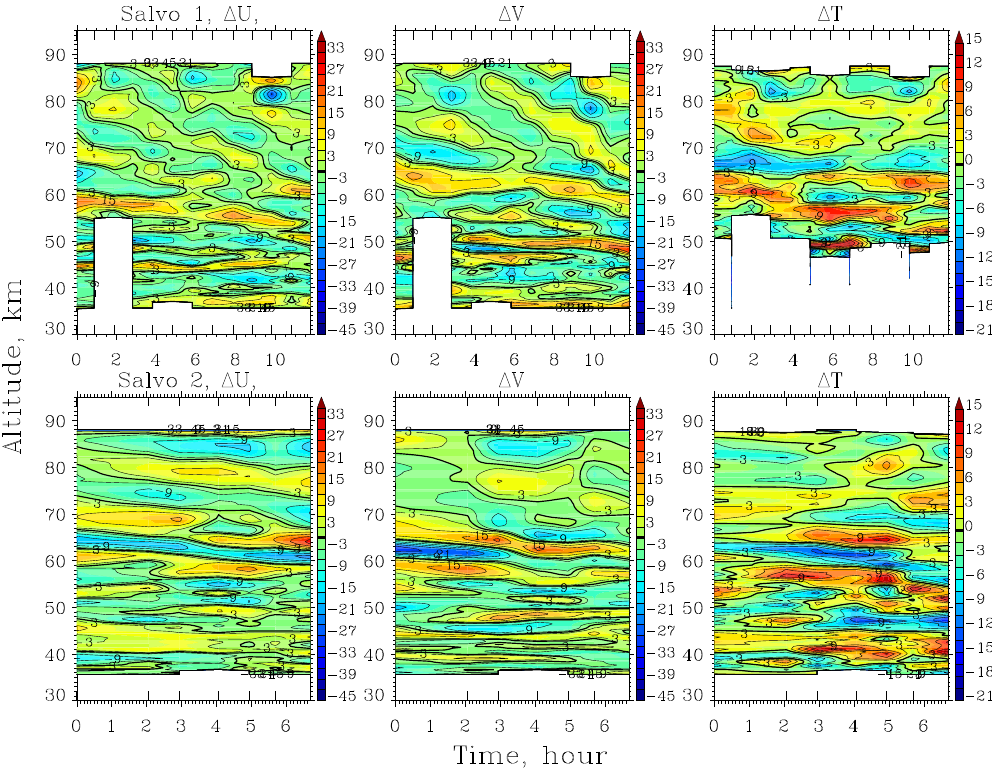
Fig. 5. Gravity wave perturbations for FS Salvo 1 and 2. The contour interval is 2ms − 1 for winds and 2 K for temperature. Times are relative to the first FS of each salvo, which were at 13:11 and 13:00 UTC,